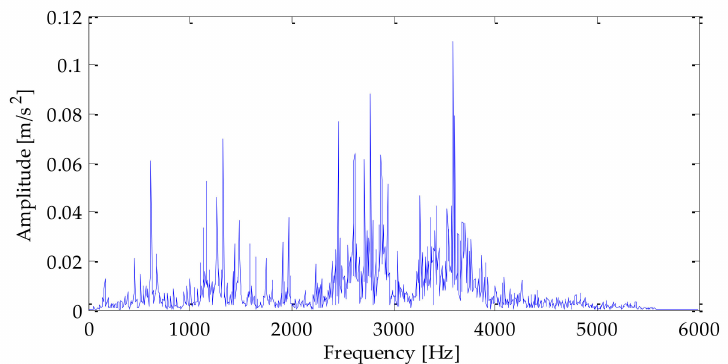
Figure 22. Frequency–domain analysis of the inner ring fault signal.